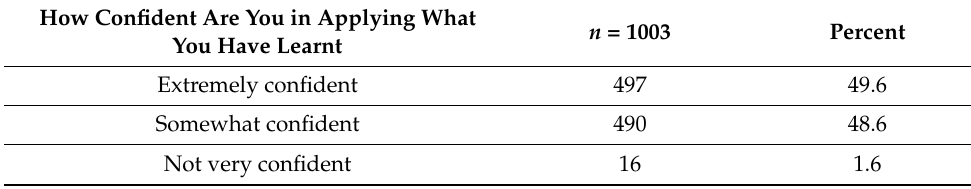
Table A4. Confidence in applying